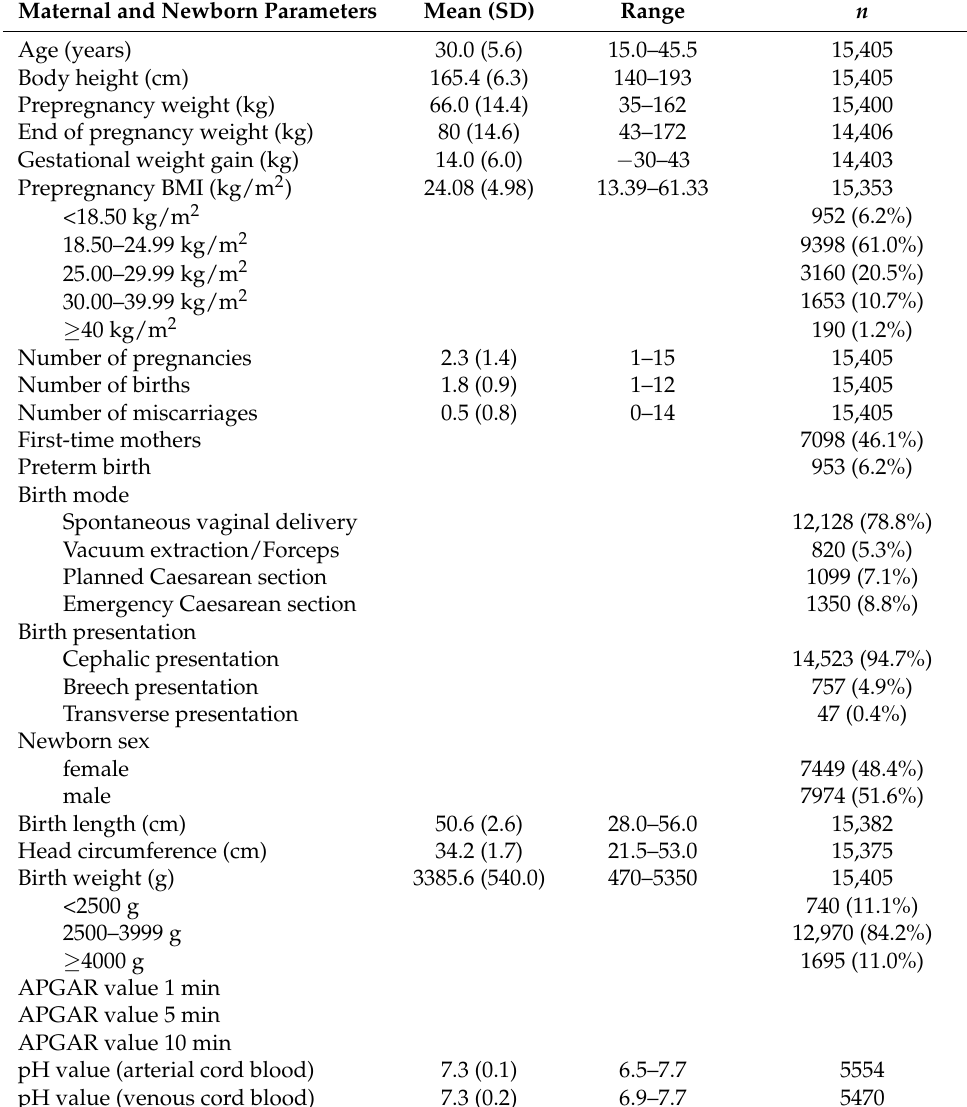
Table 1. Sample characteristics using descriptive